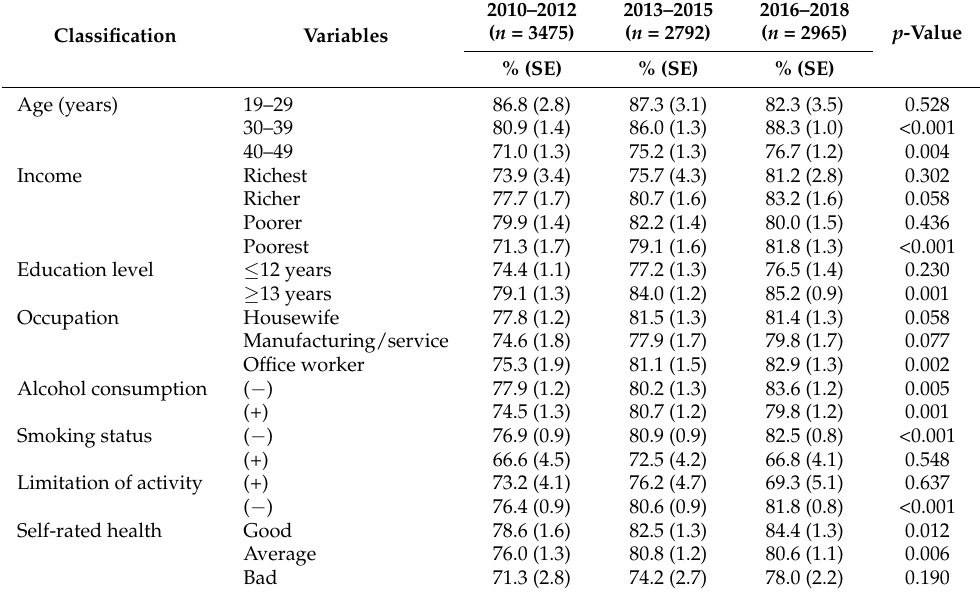
Abbreviations: SE, standard error. Data are presented as percentages (SE). * p -Values were ob- tained by using chi-squared test.